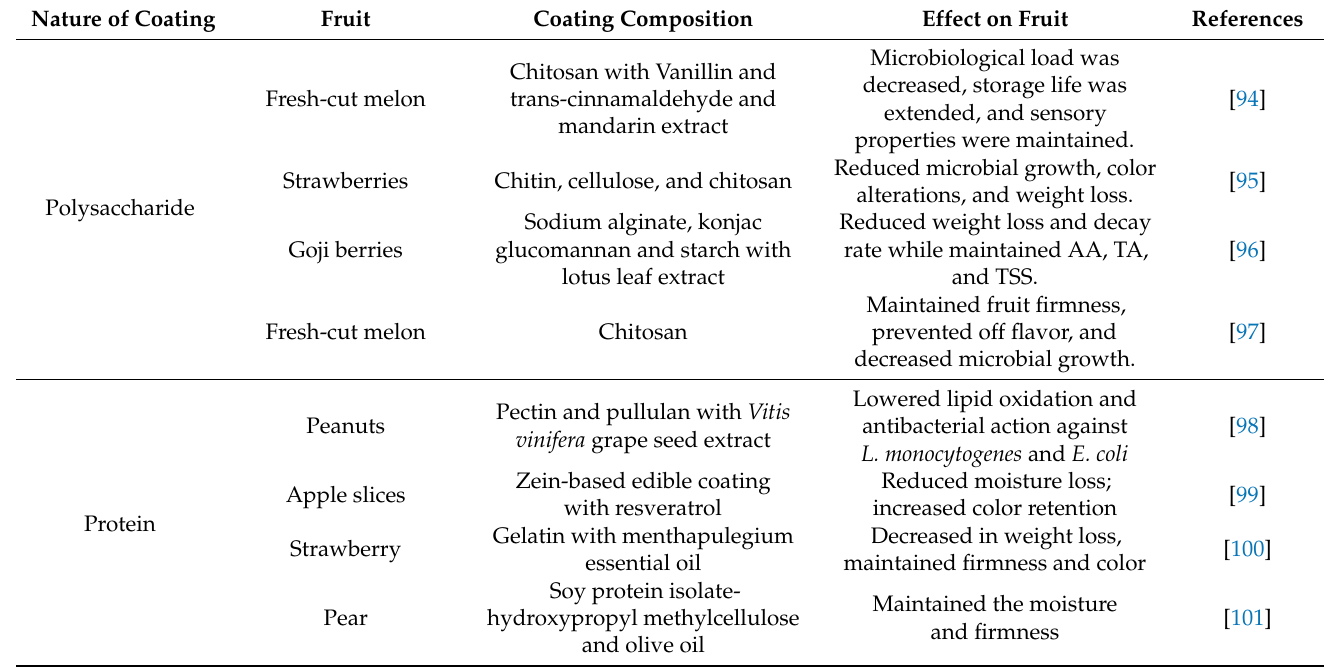
Table 3. The influence of edible coating composition on fresh fruit quality